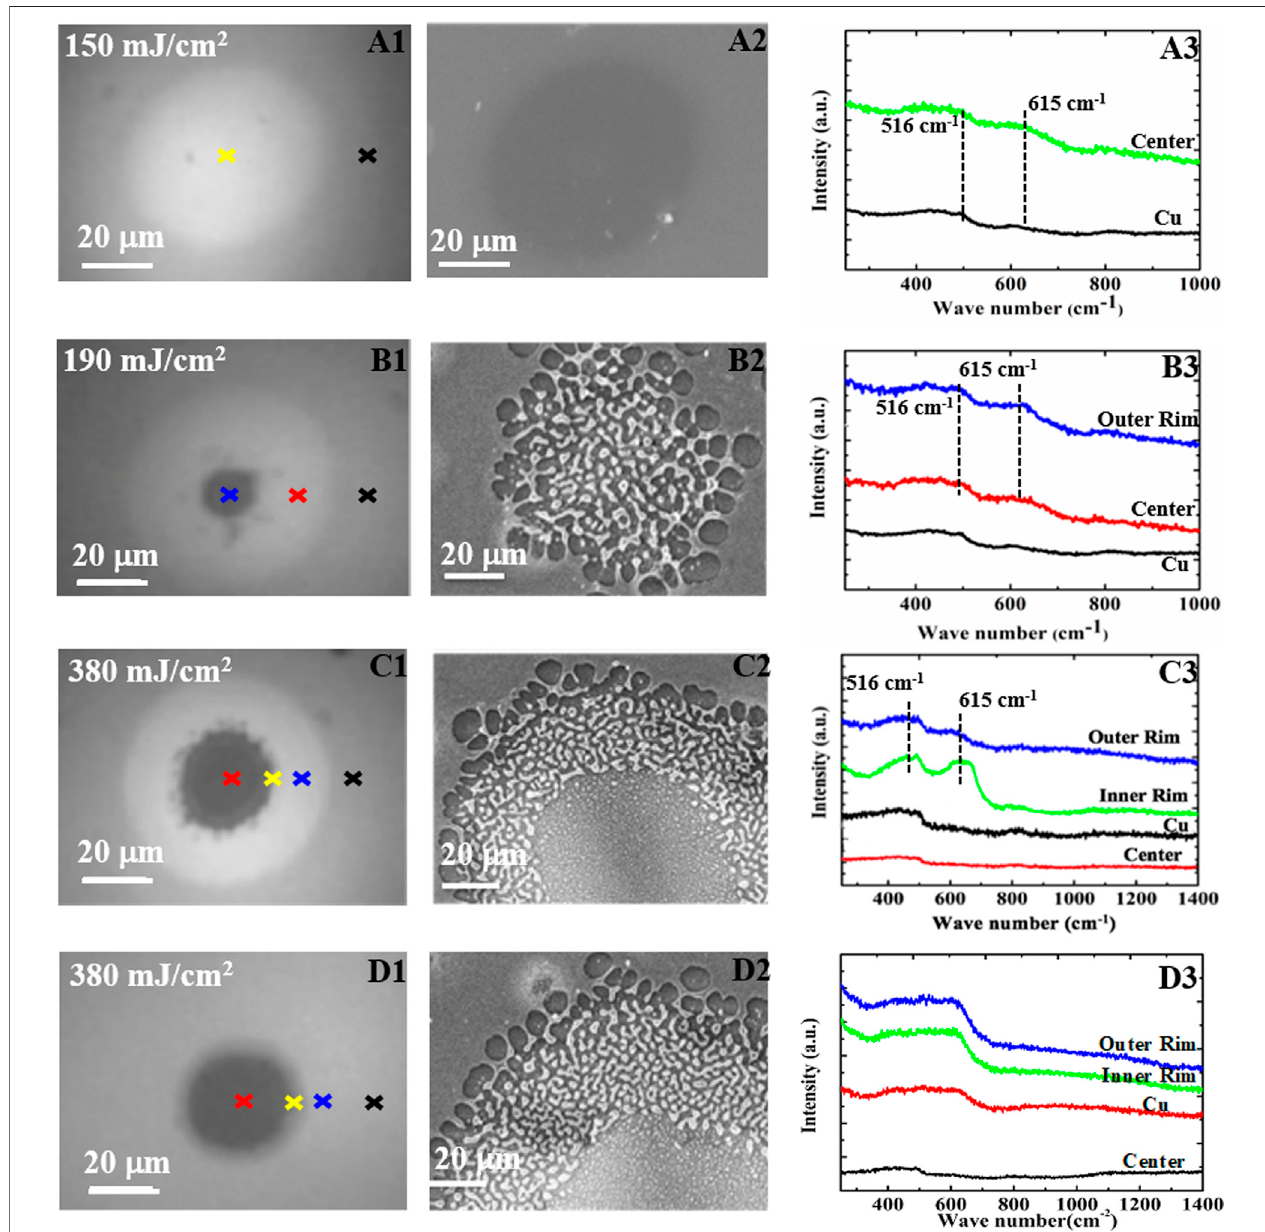
FIGURE 4 | Time-resolved optical images (a1-d1) and SEM images (a2-d2) with corresponding Raman spectra (a3-d3) for edge, rim, and center regions of dot structures shown on the right, (A) irradiated Cu at 150 mJ/cm 2 , (B) irradiated Cu at 190 mJ/cm 2 , (C) irradiated Cu at 380 mJ/cm 2 , (D) irradiated Cu at 380 mJ/cm 2 by the N 2 gas protection. The scale bars in the time-resolved optical images and SEM images are all 20 μ m.